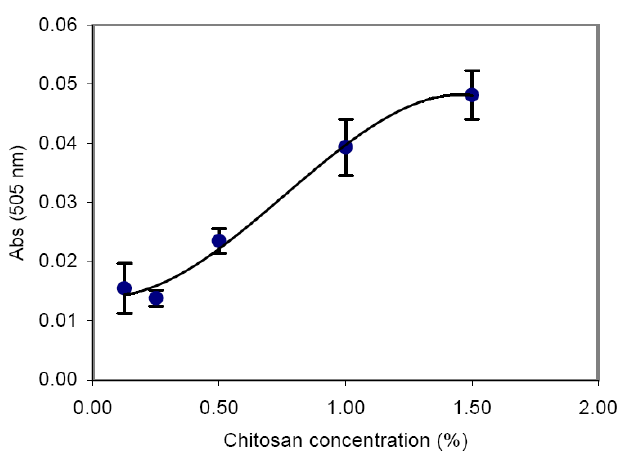
Figure 9 . The effect of the chitosan concentration on the response of